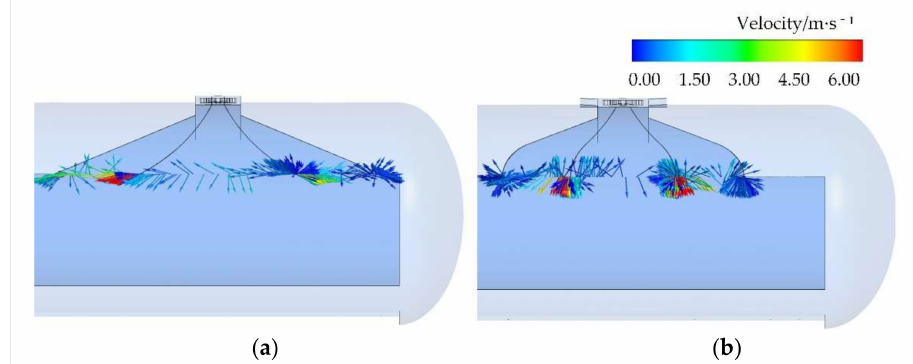
Figure 8. Air mass flow of each guide channel before and after optimization: ( a ) before optimization; ( b ) after